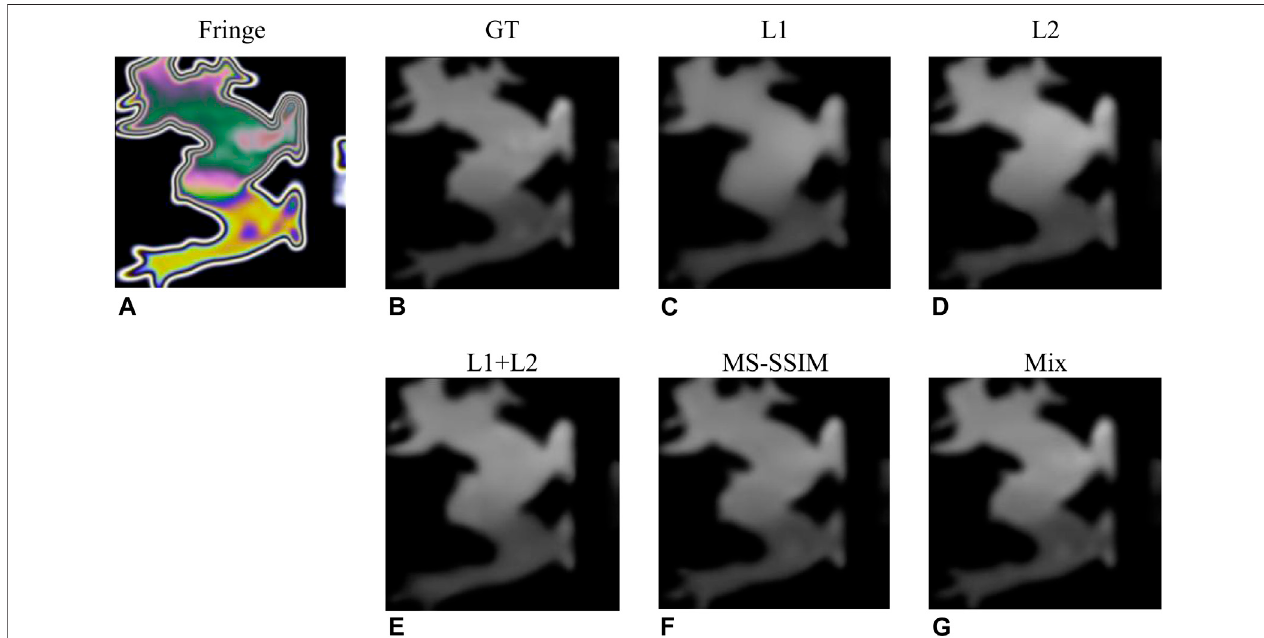
FIGURE 7 | Results for different loss functions. (A,B) are image pairs randomly selected from the test set (Briñez-de León et al., 2020e) and (C – G) are the stress maps recovered under different loss functions.